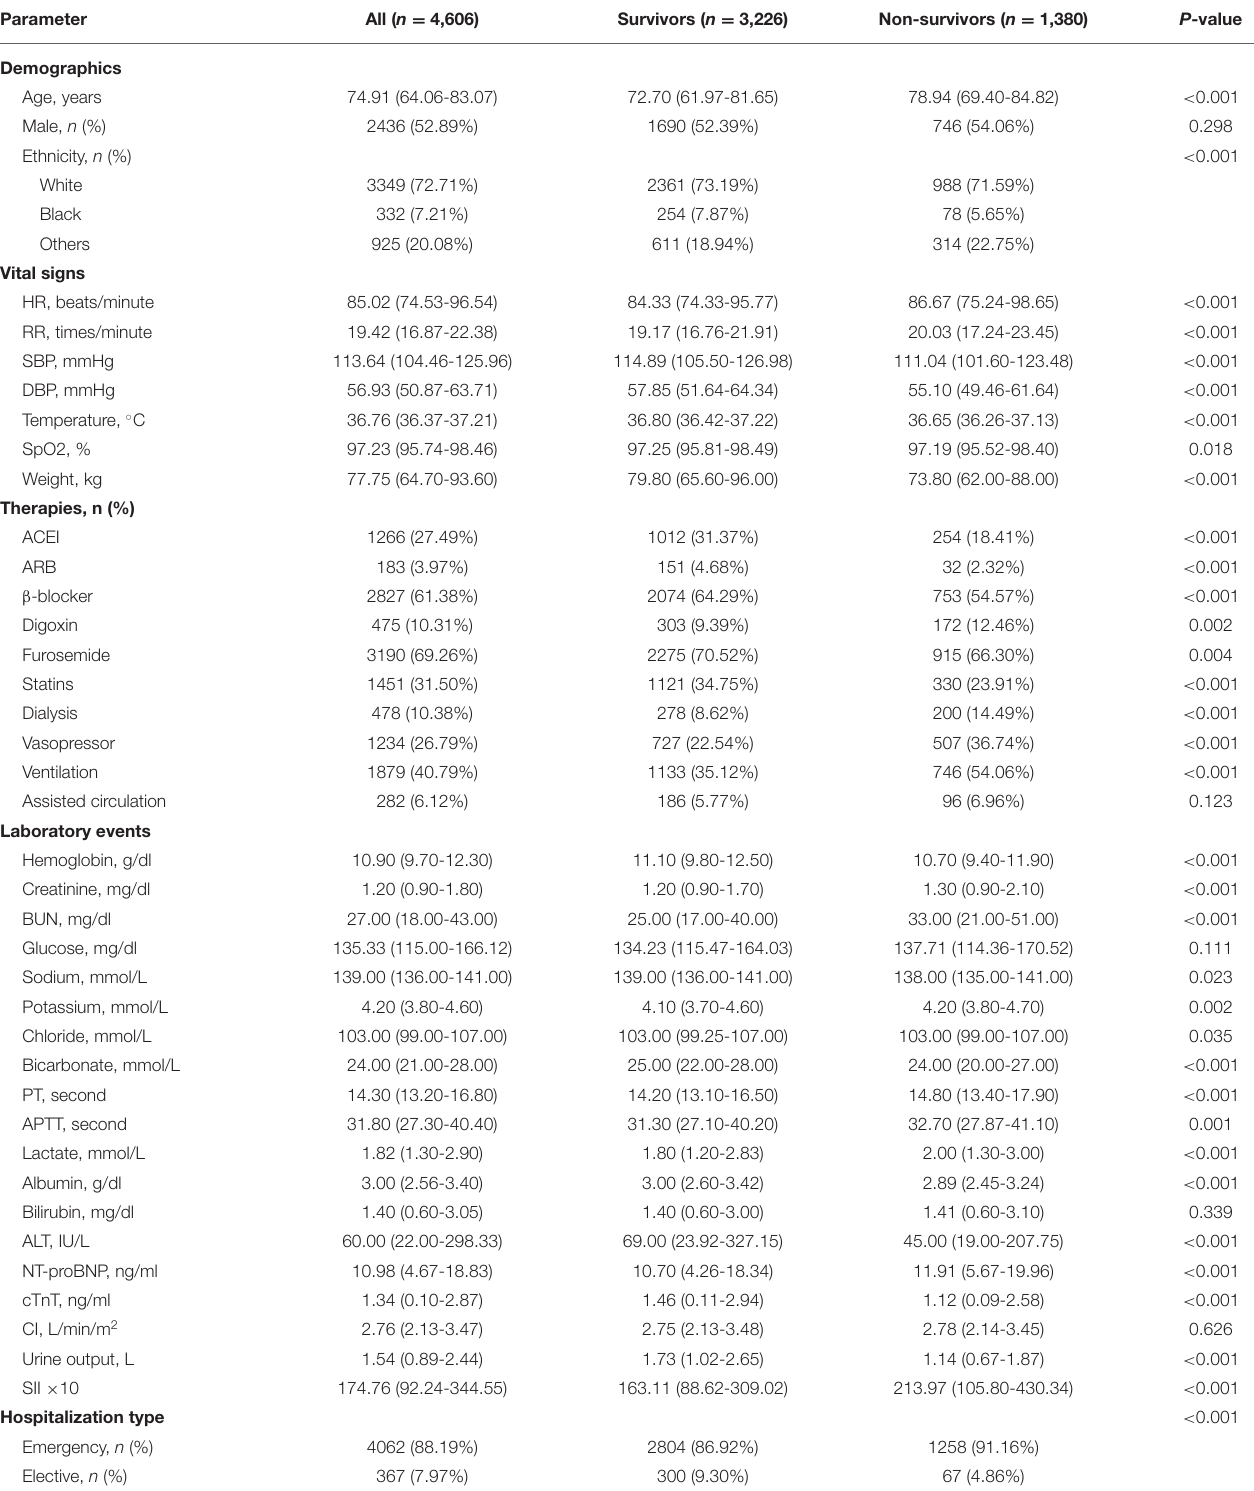
TABLE 1 | The baseline clinical characteristics of critically ill patients with CHF.